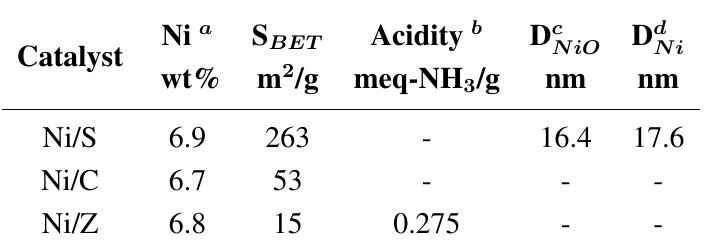
Table 1. Physicochemical properties of the reference